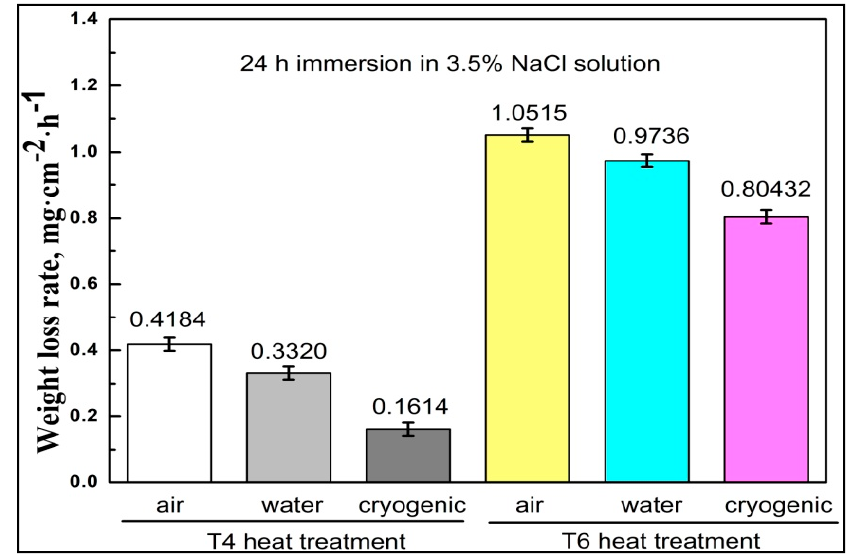
Figure 9. Weight loss rates of different Mg-7Y-1.5Nd alloy samples.